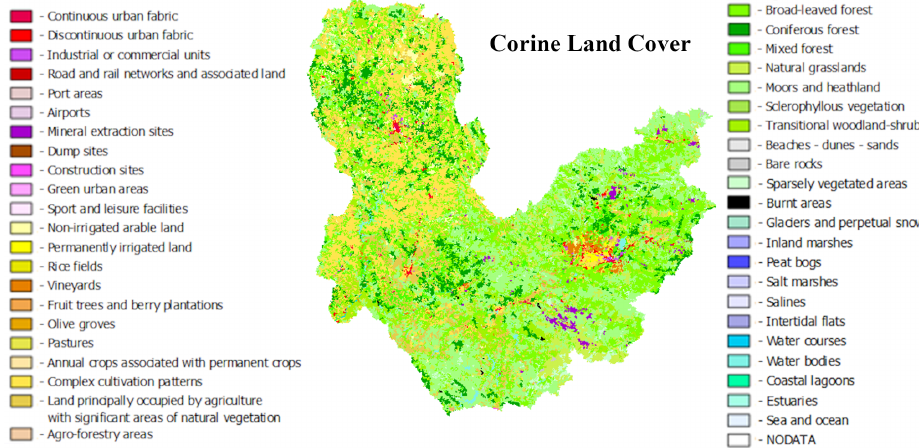
Figure 2. General land uses defined by CORINE Land Cover and their distribution for the area under